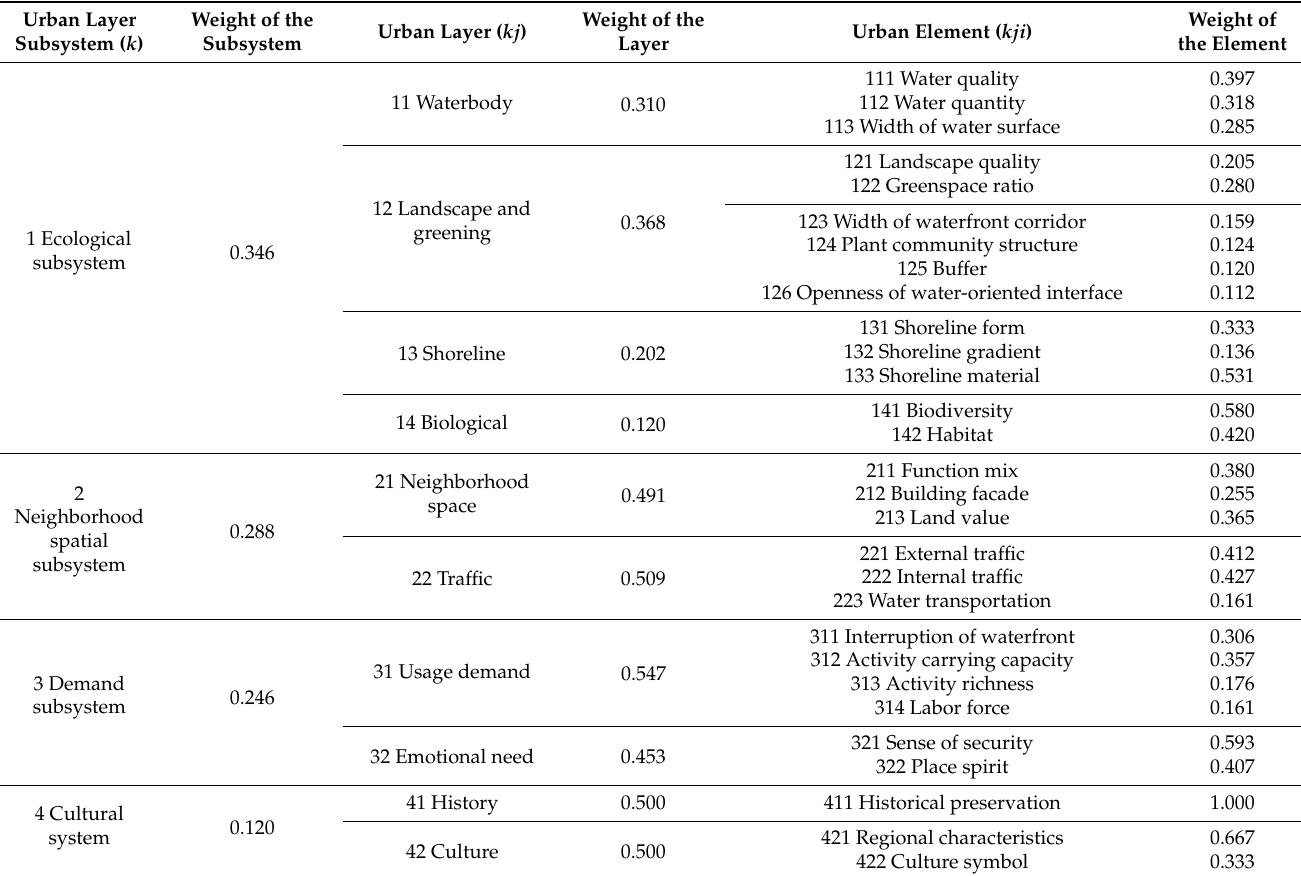
Table 5. The weights of the urban layer system.